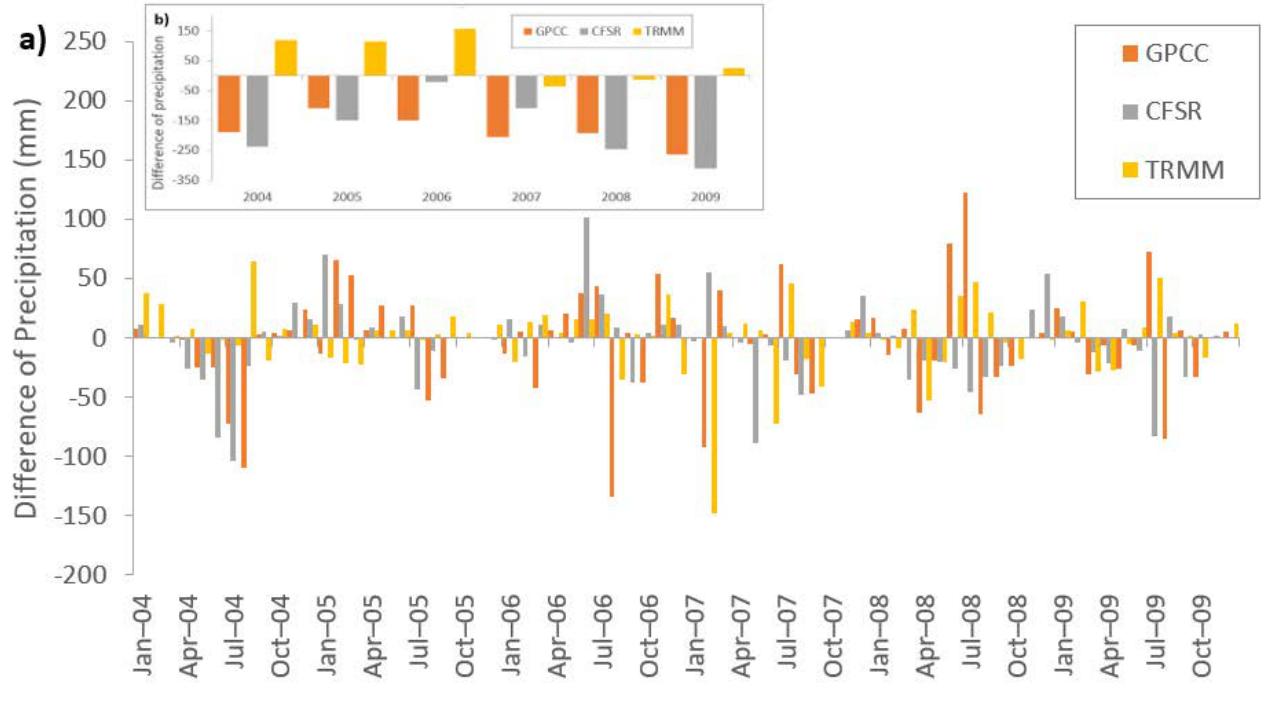
Figure 3. Difference between gridded precipitation and gauge data: ( a ) on a monthly basis, ( b ) on an annual